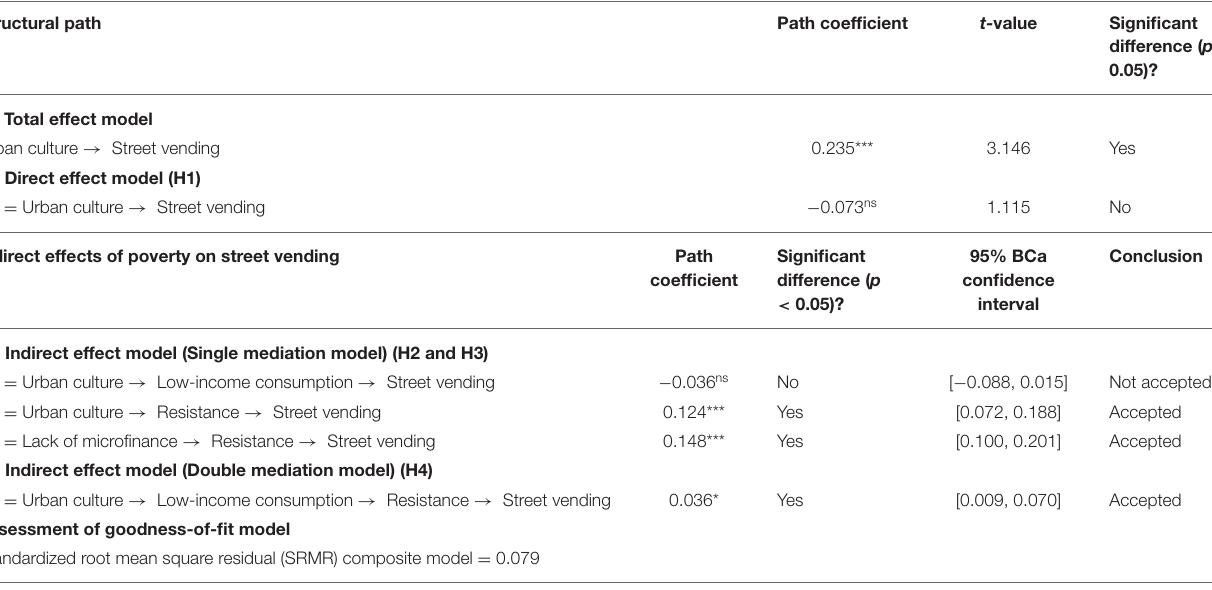
TABLE 6 | Summary of mediating analyses. Structural